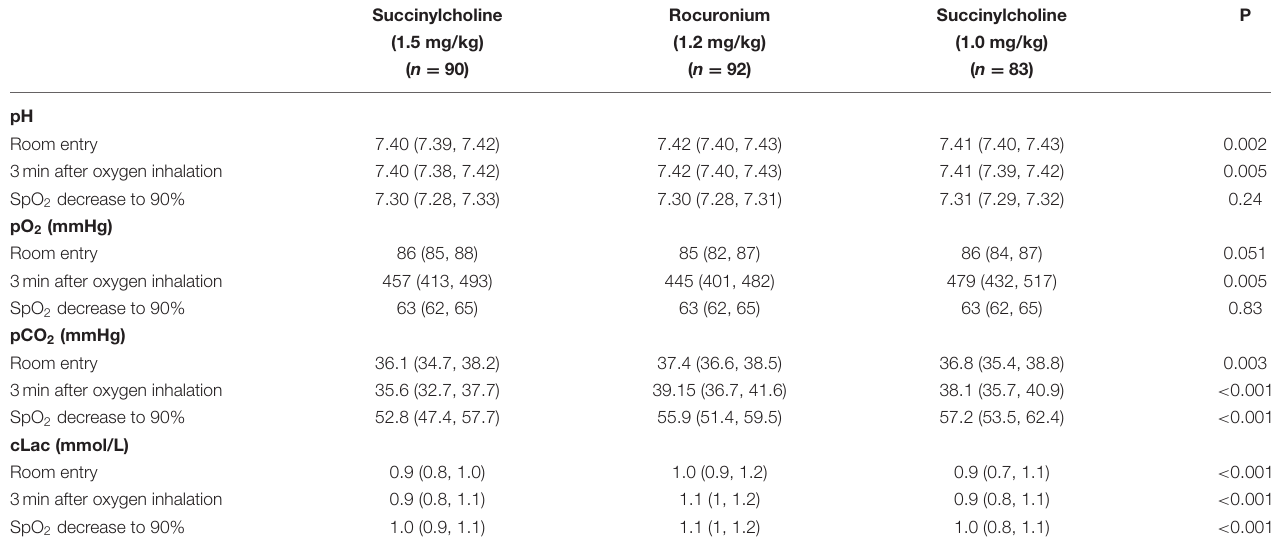
TABLE 4 | Blood gas